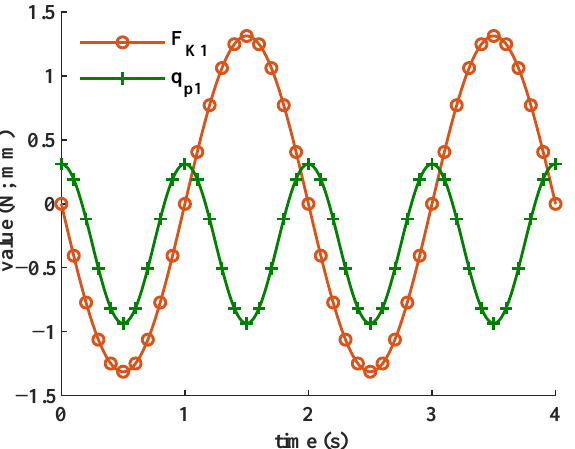
Figure 12. Stiffness-related component, F K 1 , of the required active force, and the corresponding flexure-based passive prismatic joint displacement q p 1 .